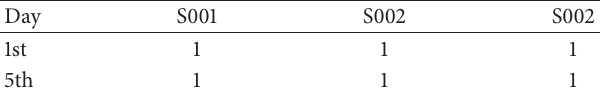
Table 3: SEFRE clinical trial result of 3 subjects: muscle